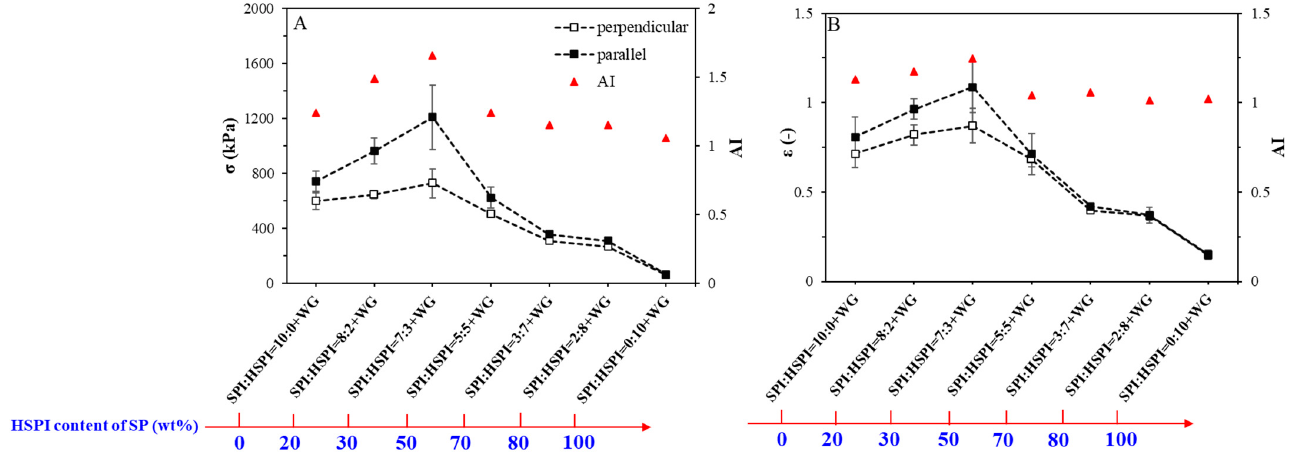
Figure 6. Tensile properties of extrudates: Fracture stress σ ( A ) and fracture strain ε ( B ). The ratio between the averages of the parallel (black bars) and perpendicular directions (white bars) is a measure of anisotropy (AI, red triangles). The dashed lines guide the eye.